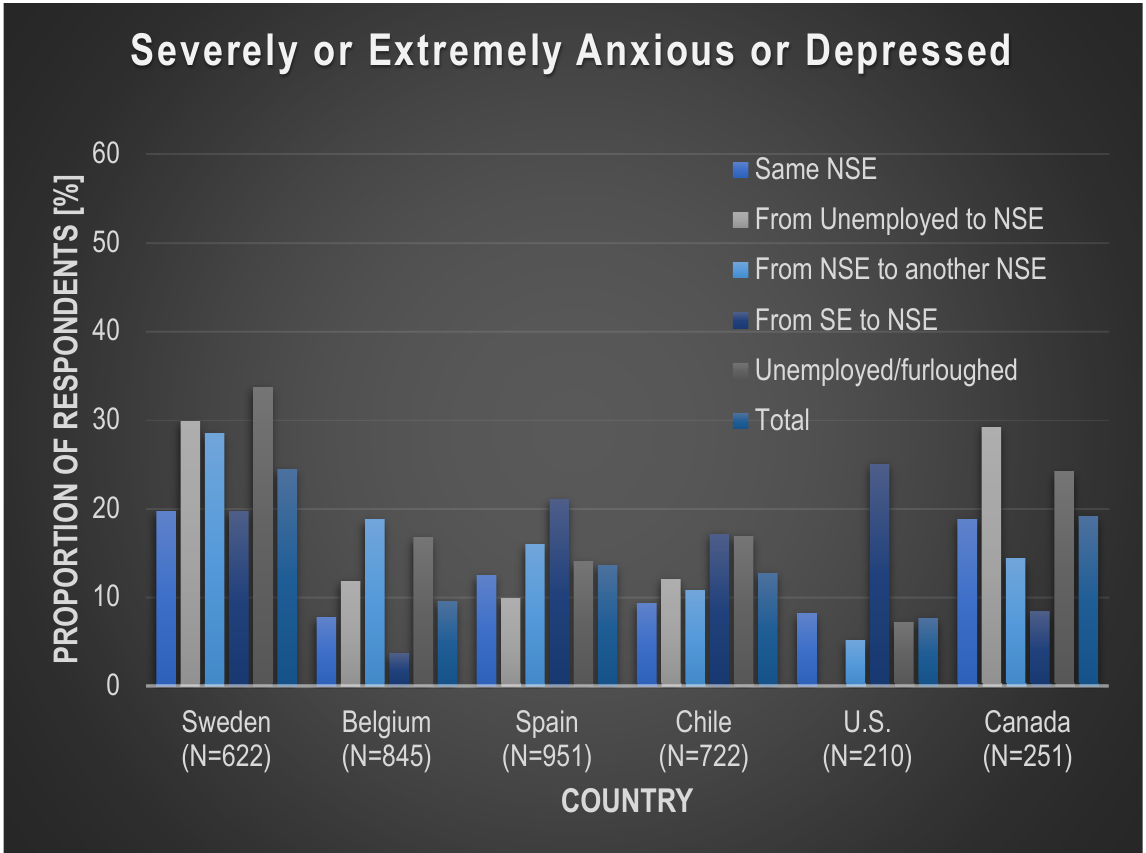
Figure 2. Proportion of respondents indicating that they are severely or extremely anxious or depressed, by country and by employment transition. Notes: For each country, N represents the total sample of participants with jointly defined values for the employment transitions and the self-declared anxiety and depression questions.